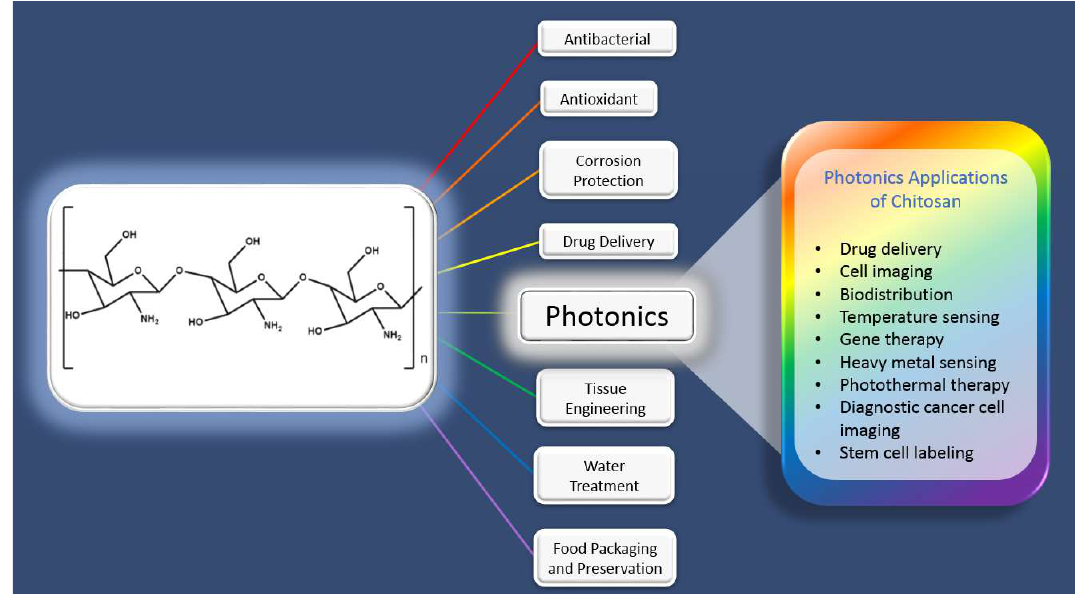
Figure 1. Schematic illustration showing different applications of chitosan (CS), highlighting the photonic applications of CS and its derivatives.